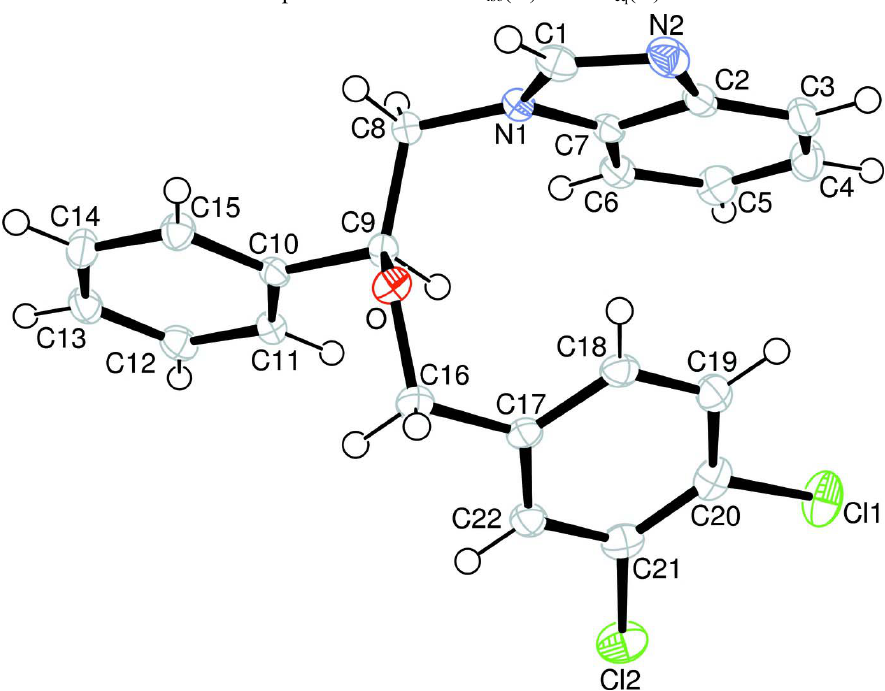
The molecular structure of the title molecule with the atom-numbering scheme. Displacement ellipsoids are drawn at the 50% probability